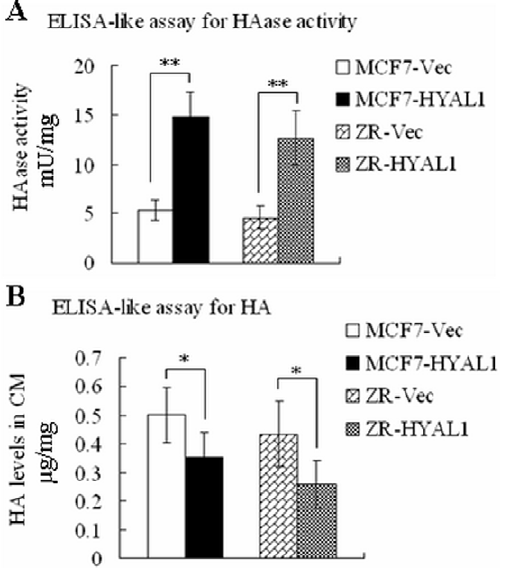
Figure 3. Summary of HAase activity and HA expression by ELISA-like assay. In MCF7 and ZR-75-30 cells, the HAase activity was increased significantly by pcDNA3.1-HYAL1 transfectants (A; p , 0.01). However, the HA expression was decreased (B; p ,